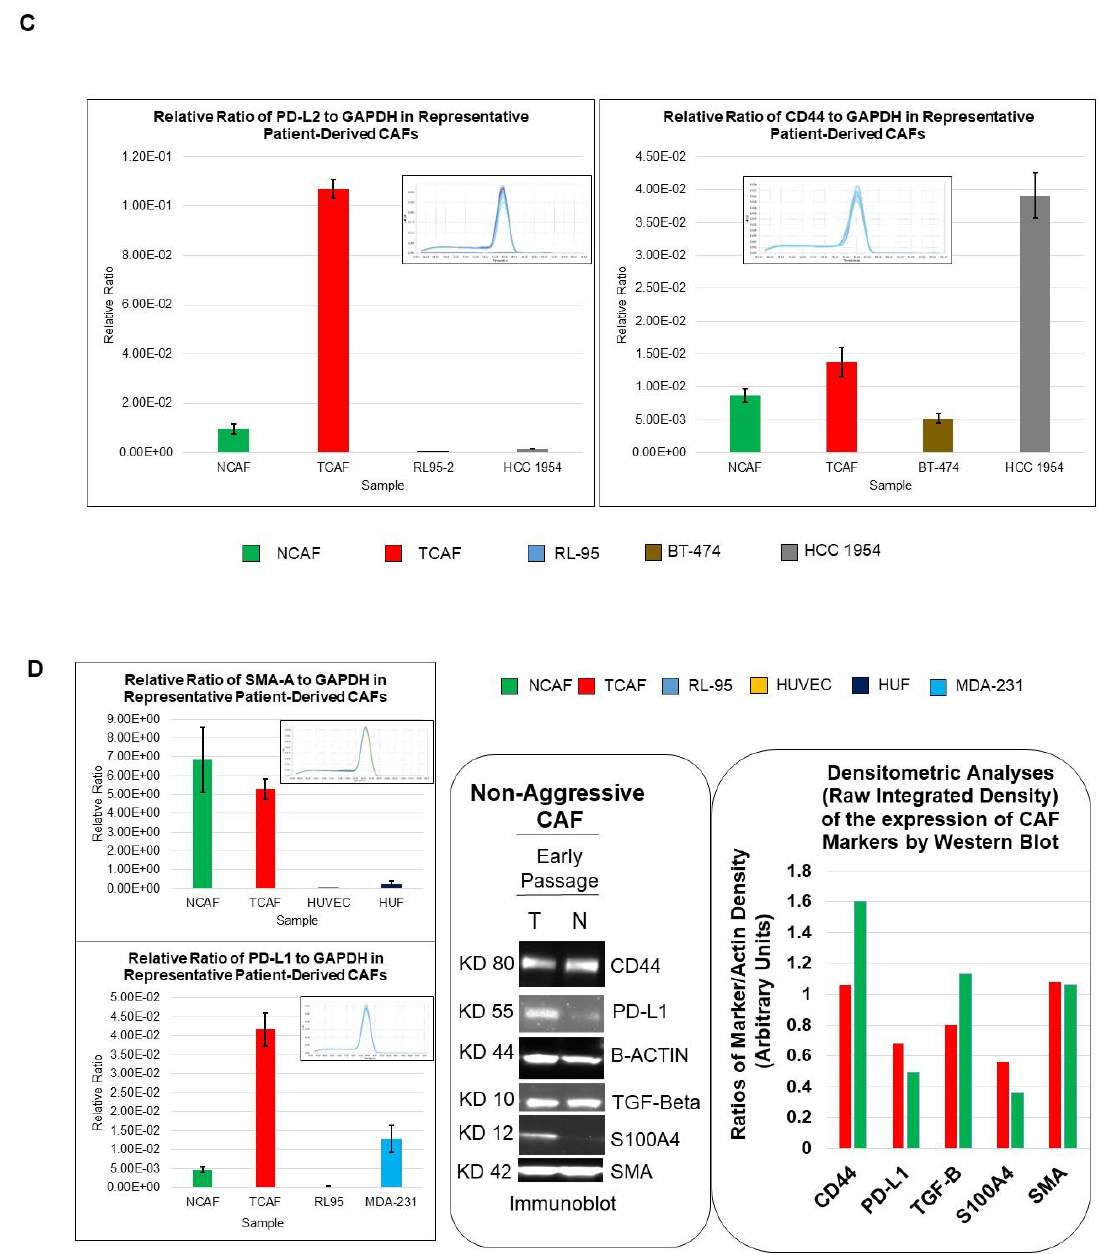
Figure 1. Expression of mRNA for marker proteins of CAF by qRT-PCR: Each graph represents the expression of a gene of interest presented as its relative ratio to GAPDH . Inset in each graph is a melting curve of the gene of interest. CAF samples and the positive and negative controls for each gene are color-coded and listed at the bottom of the figure. ( A ) presents expressions of three negative markers of CAF, endothelial marker ( CD31 ), epithelial marker ( EpCAM ), and common leucocyte antigen ( CD45 ), in NCAFs and TCAFs with respective validation controls. ( B ) presents expressions of four positive markers of CAF ( FAP-A , S100A4, PDGFR-A , and FGFR-1 ) in NCAFs and TCAFs with respective validation controls. ( C ) presents expressions of PD-L2 and CD44 in NCAFs and TCAFs with respective validation controls. ( D ) compares the qRT-PCR expression of markers with the protein expression of the same markers (SMA and PD-L1) by WB (inset) from a representative non-aggressive early passage NCAF and TCAF. The expressions of CD44, TGFB, and S100A4 by WB are also presented with the corresponding densitometric analyses (bar diagrams) using Image J. Beta-actin was used as the loading control.